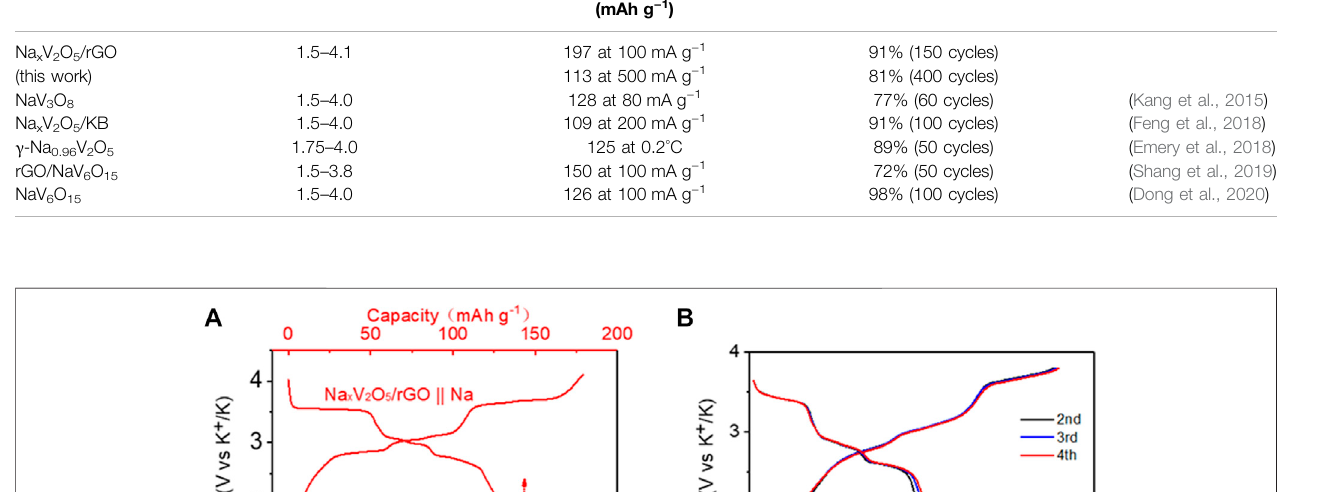
Frontiers in Materials |